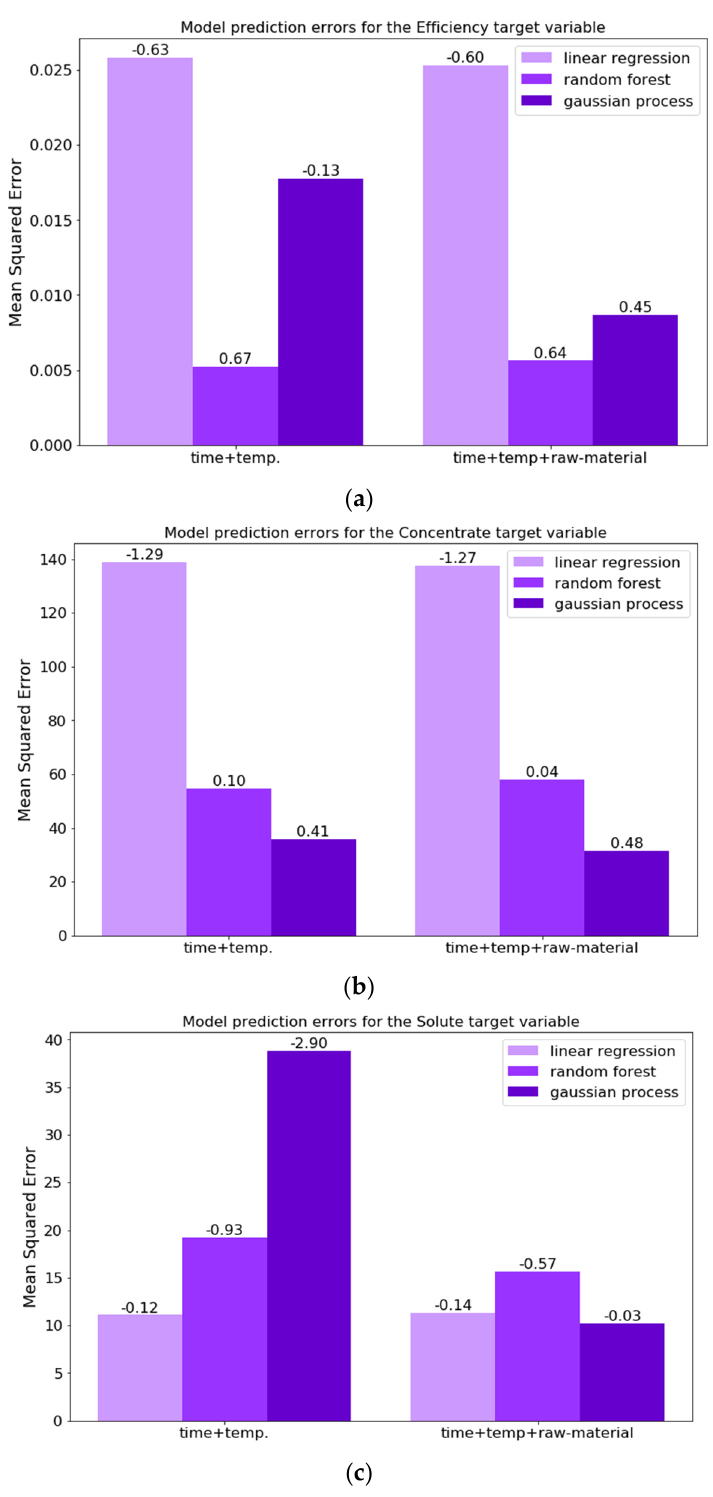
Figure 5. Results of the regression models: ( a ) efficiency, ( b ) percentage of concentrate and ( c ) recuperated solute.